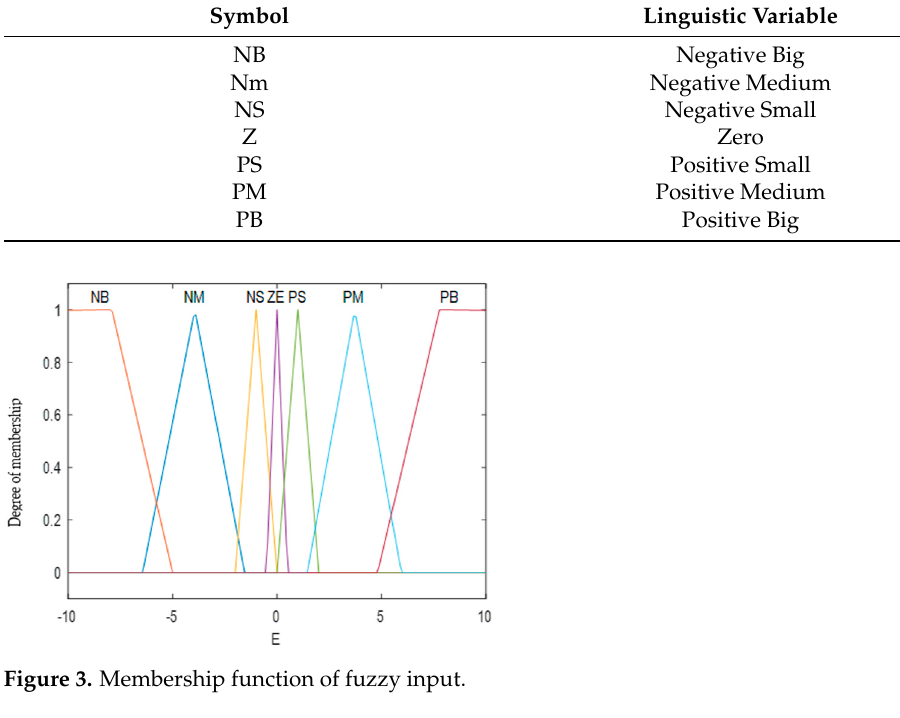
Figure 5. Membership function of fuzzy output variable (u). Table 3. Rules of FL controller [18]. Error